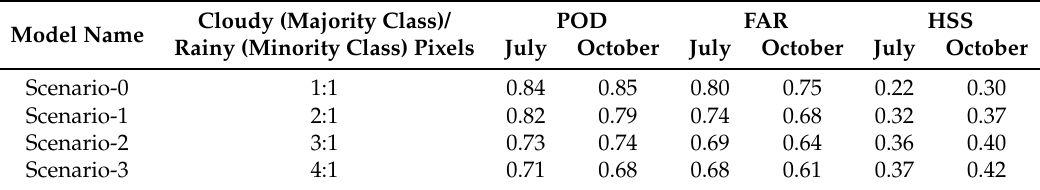
Table 3. Validation scores for RF classification with different class ratios.